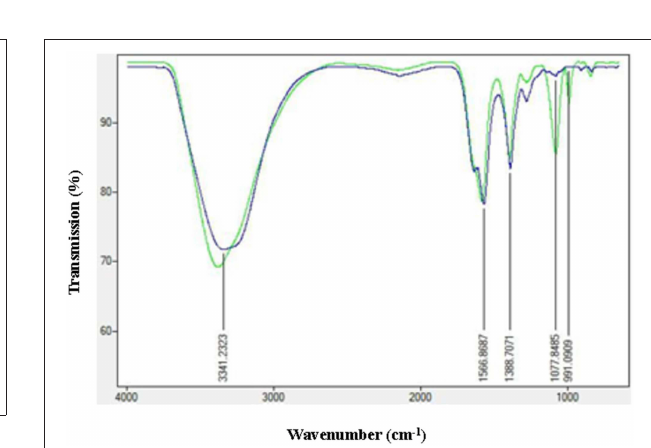
FIGURE 5 | FTIR spectra of AgNPs before and after adsorption with AiiA. Presence of conspicuous peaks at 1,077 nm − 1 and 991 nm − 1 indicate toward the interaction between AiiA and